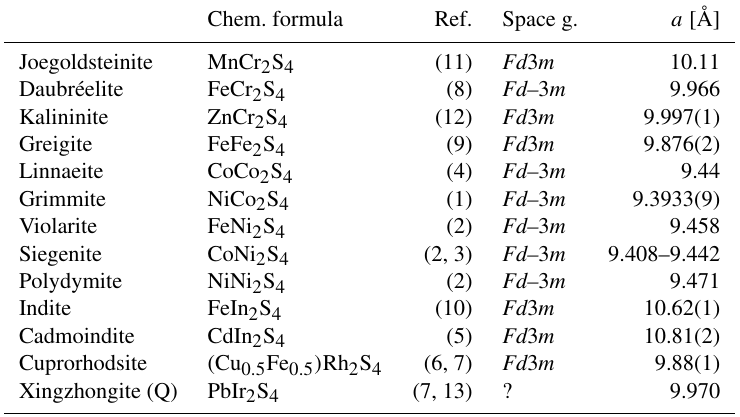
Table 7. Members of the thiospinel group and linnaeite subgroup. Minerals are listed according to the increasing atomic number of the main cation. Chem. formula Ref. Space g.